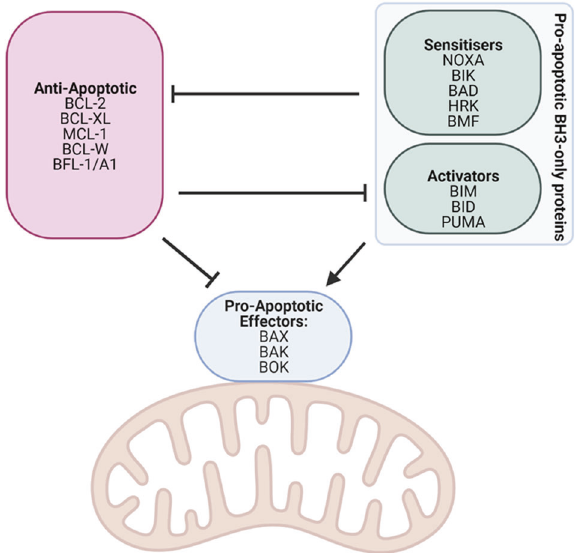
Fig. 3 BCL-2 protein family interactions. The BCL-2 protein family interactions mediate BAX/BAK-induced mitochondrial outer mem- brane permeabilisation (MOMP). Created with